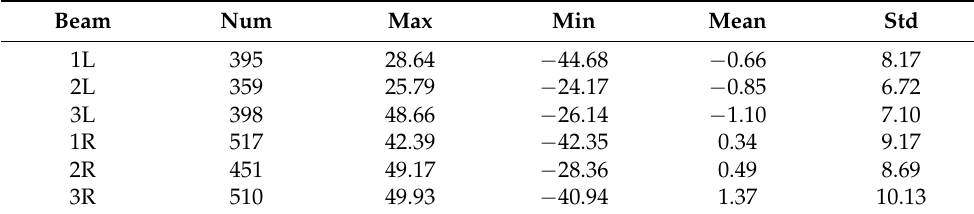
Table 3. Differences in SSHs at the self-crossover points of ICESat-2 within 10 days (Unit: cm). Beam